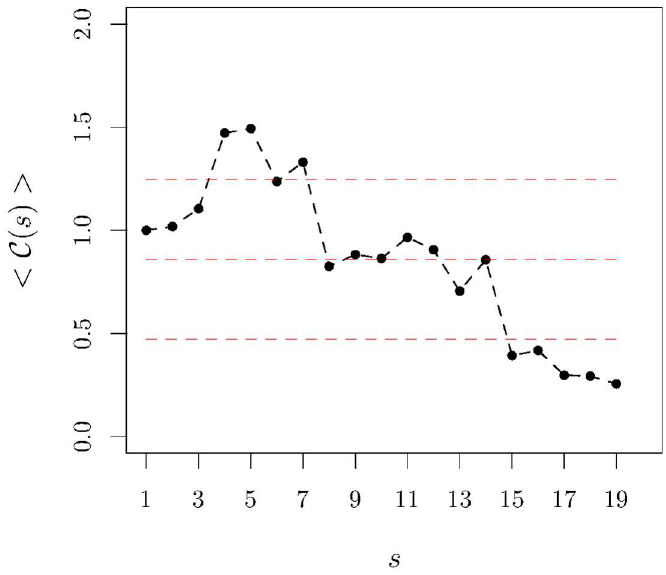
Fig 4. Concavity of the average traded volume v semester s . The black dots—with the black line as a guide to the eye—represent the values of the concavity averagedover companies normalised by the value of h C ð 1 Þi ; the horizontal lines signalthe average value (computedover all companiesand semesters) and the upper and lower error limits. It is clear the concavity of the average traded volume has